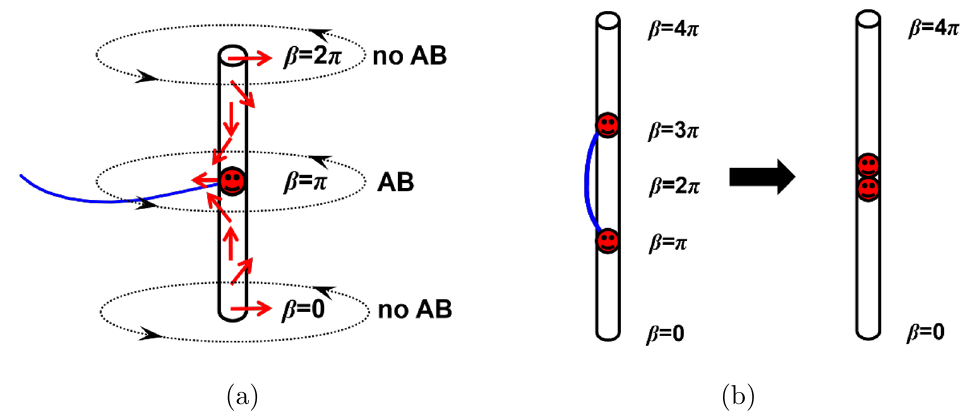
Figure 6 . Monopole(s) on a string attached by AB defect(s) in the deconfined phase. (a) a single monopole on a string attached by an AB defect. Circles imply Wilson loops linking the string, which are trivial far from the monopole and exhibit an nontrivial AB phase around the monopole. (b) two monopoles on a string connected by an AB defect (left) and a monopole meson on a string